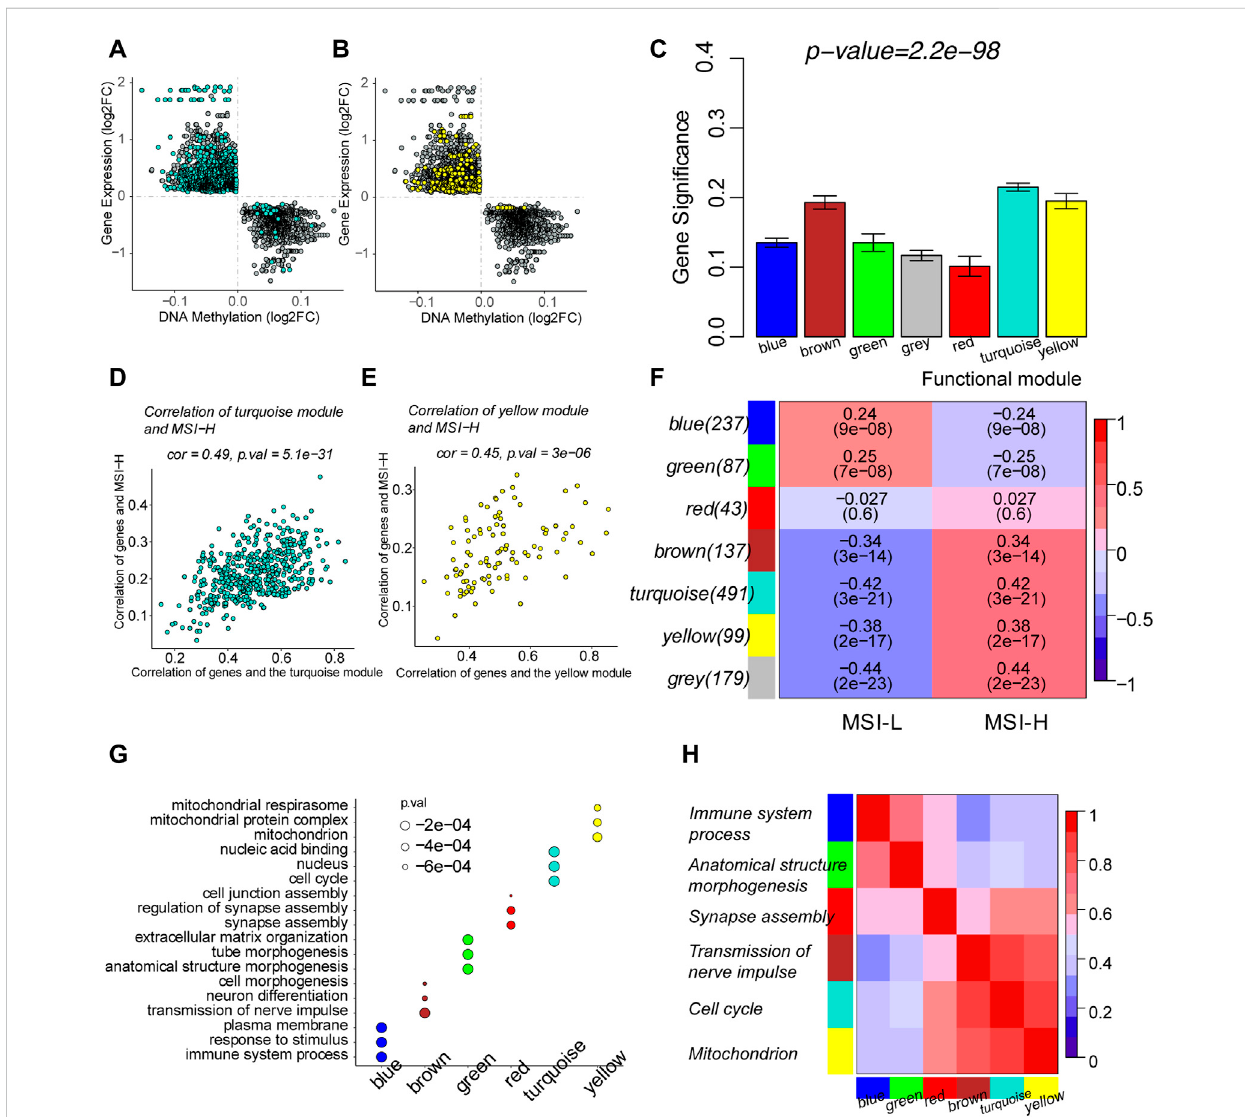
FIGURE 5 Identi fi cation of MSI-related functional gene modules by weighted correlation network analysis (WGCNA). (A) Scatterplots of the log2FC of DMPs and DEGs in the turquoise module. (B) Scatterplots of the log2FC of DMPs and DEGs in the yellow module. (C) Barplot of mean gene signi fi cance (GS) of each module. GS was de fi ned as the absolute value of the correlation between the gene and the clinical phenotype. Since modules were clusters of functionalgenes,themeanGSofeachmodulewascorrelatedwithGSofeachgeneinthemodule. (D) Scatterplotsshowedthecorrelationbetween GSand modulemembership(MM)intheturquoise module.MM wasde fi ned asthecorrelationbetween thesummarypro fi le ofthemodule andthegene expression. (E) Scatterplots showed the correlation between GS and MM in the yellow module. (F) Relationship between functional modules and MSI phenotypes. Each row corresponded to a module containing functional genes, column to the MSI status. Each cell contains the corresponding correlation and p -value. The table is color-coded by correlation, according to the color legend. (G) Top three enriched biological processes of